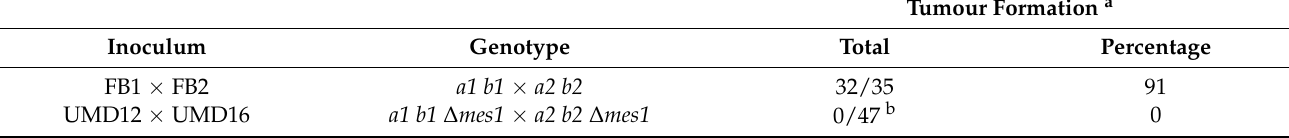
Table 1. Pathogenicity